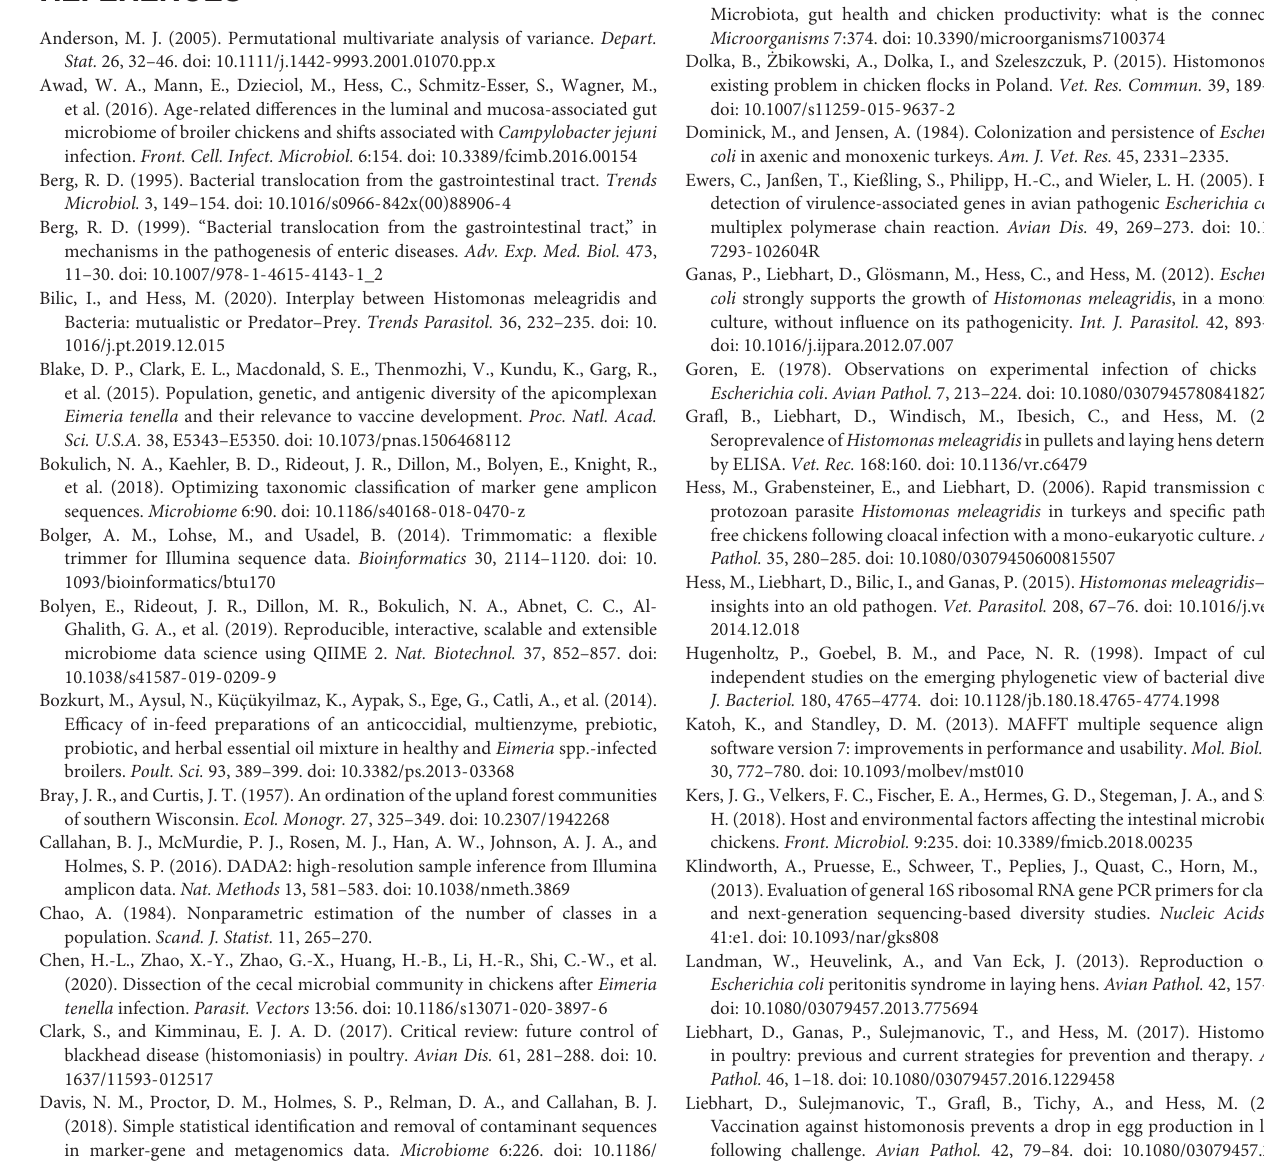
E. coli and negative control.